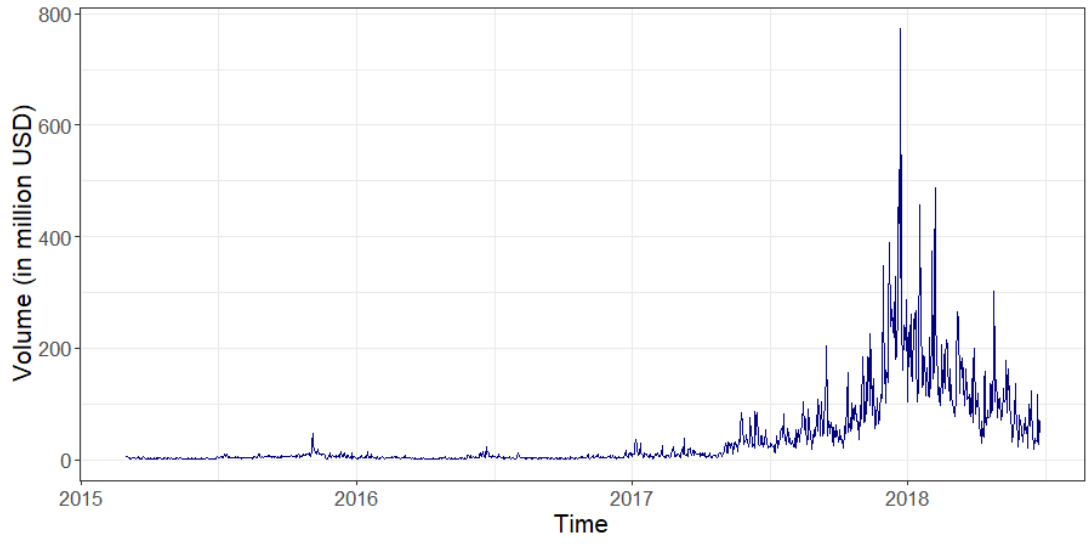
Fig. 4. Daily Bitcoin trading volume (in million US Dollars) on the Bitstamp